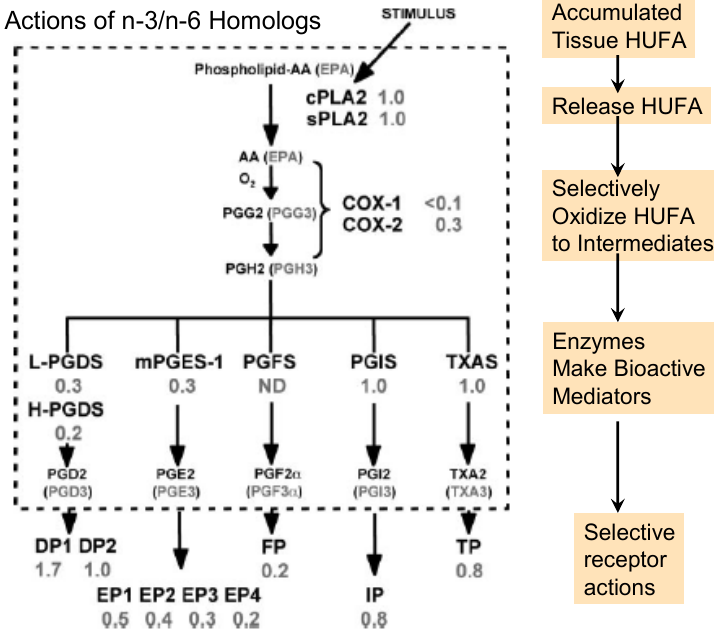
Figure 2. Selective events for n -3 and n -6 homologs during prostaglandin formation and action. The number beside each event shows the efficacy of the n -3 homolog relative to the n -6 homolog. Abbreviations for the enzymes and receptors are: cPLA2, cytosolic phospholipase A2; sPLA2, soluble phospholipase A2; COX-1, cyclooxygenase-1; COX-2, cyclooxygenase-2; L-PGDS, lipocalin prostaglandin D synthase; H-PGDS, hematopoietic prostaglandin D synthase; m-PGES-1, microsomal prostaglandin E synthase-1; PGFS, prostaglandin F synthase; PGIS, prostaglandin I synthase; TXAS, thromboxane synthase; DP, prostaglandin D receptors (1–2); EP, prostaglandin E receptors (1–4); IP, prostaglandin I receptor; TP, thromboxane receptor. The figure is modified from that published by Wada et al.